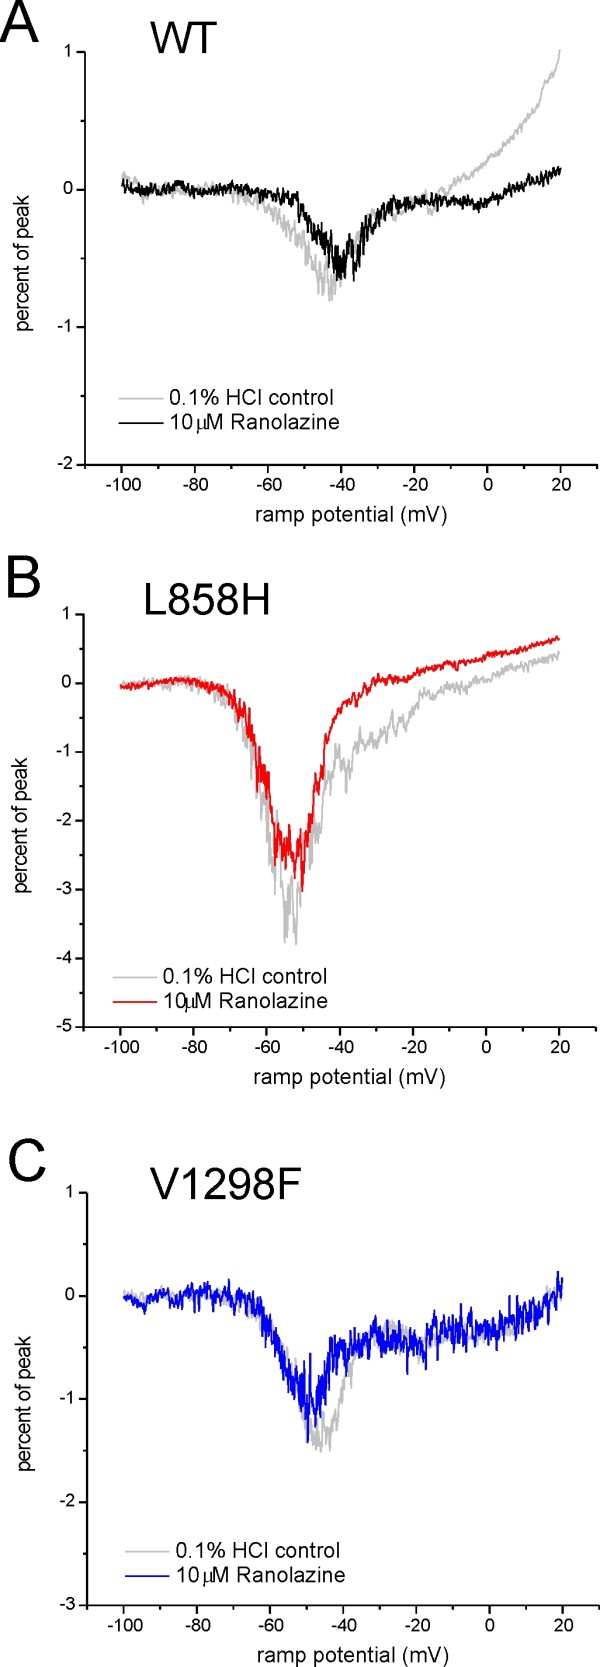
Ranolazine block of ramp currents. The response to slow gradual depolarization (ramp) stimulus protocol (-100 mV to +20 mV over 600 msec) from representative cells is normalized to the peak inward current for that cell as described in Methods. Separate cells were exposed to either 0.1% HCl vehicle control (grey line) or 10 μM ranolazine (bold line). In each panel the two traces are overlaid to compare the response to ranolazine. (A) HEK 293 cells expressing WT show a peak ramp response of 0.58 ± 0.15% and the voltage peaks at -43.0 ± 1.2 mV in the presence of 0.1% HCl vehicle control (n = 3). In the presence of 10 μM ranolazine (n = 4), the peak ramp response was 0.79 ± 0.22% and the voltage peaks at -48.0 ± 3.9 mV. (B) HEK 293 cells expressing, the IEM mutant L858H show a peak ramp response of 4.48 ± 1.13% and the voltage peaks at -55.8 ± 2.2 mV in the presence of 0.1% HCl vehicle control (n = 5). In the presence of 10 μM ranolazine (n = 4), the peak ramp response was 3.31 ± 0.60% and the voltage peaks at -54.1 ± 2.0 mV. (C) HEK 293 cells expressing the PEPD mutant V1298F show a peak ramp response of 1.05 ± 0.21% and the voltage peaks at -48.5 ± 2.2 mV in the presence of 0.1% HCl vehicle control (n = 8). In the presence of 10 μM ranolazine (n = 7), the peak ramp response was 0.84 ± 0.11% and the voltage peaks at -49.7 ± 2.7 mV.